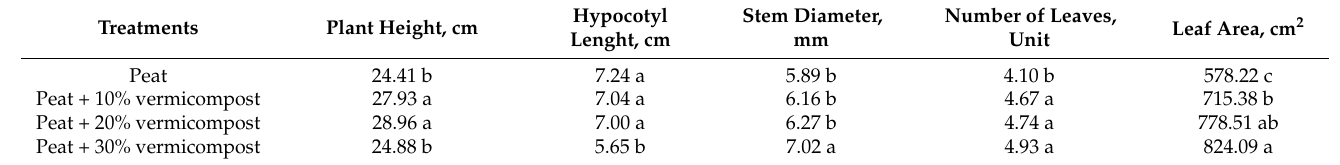
Table 2. The effect of peat–vermicompost substrates on the biometric parameters of cucumber seedlings.